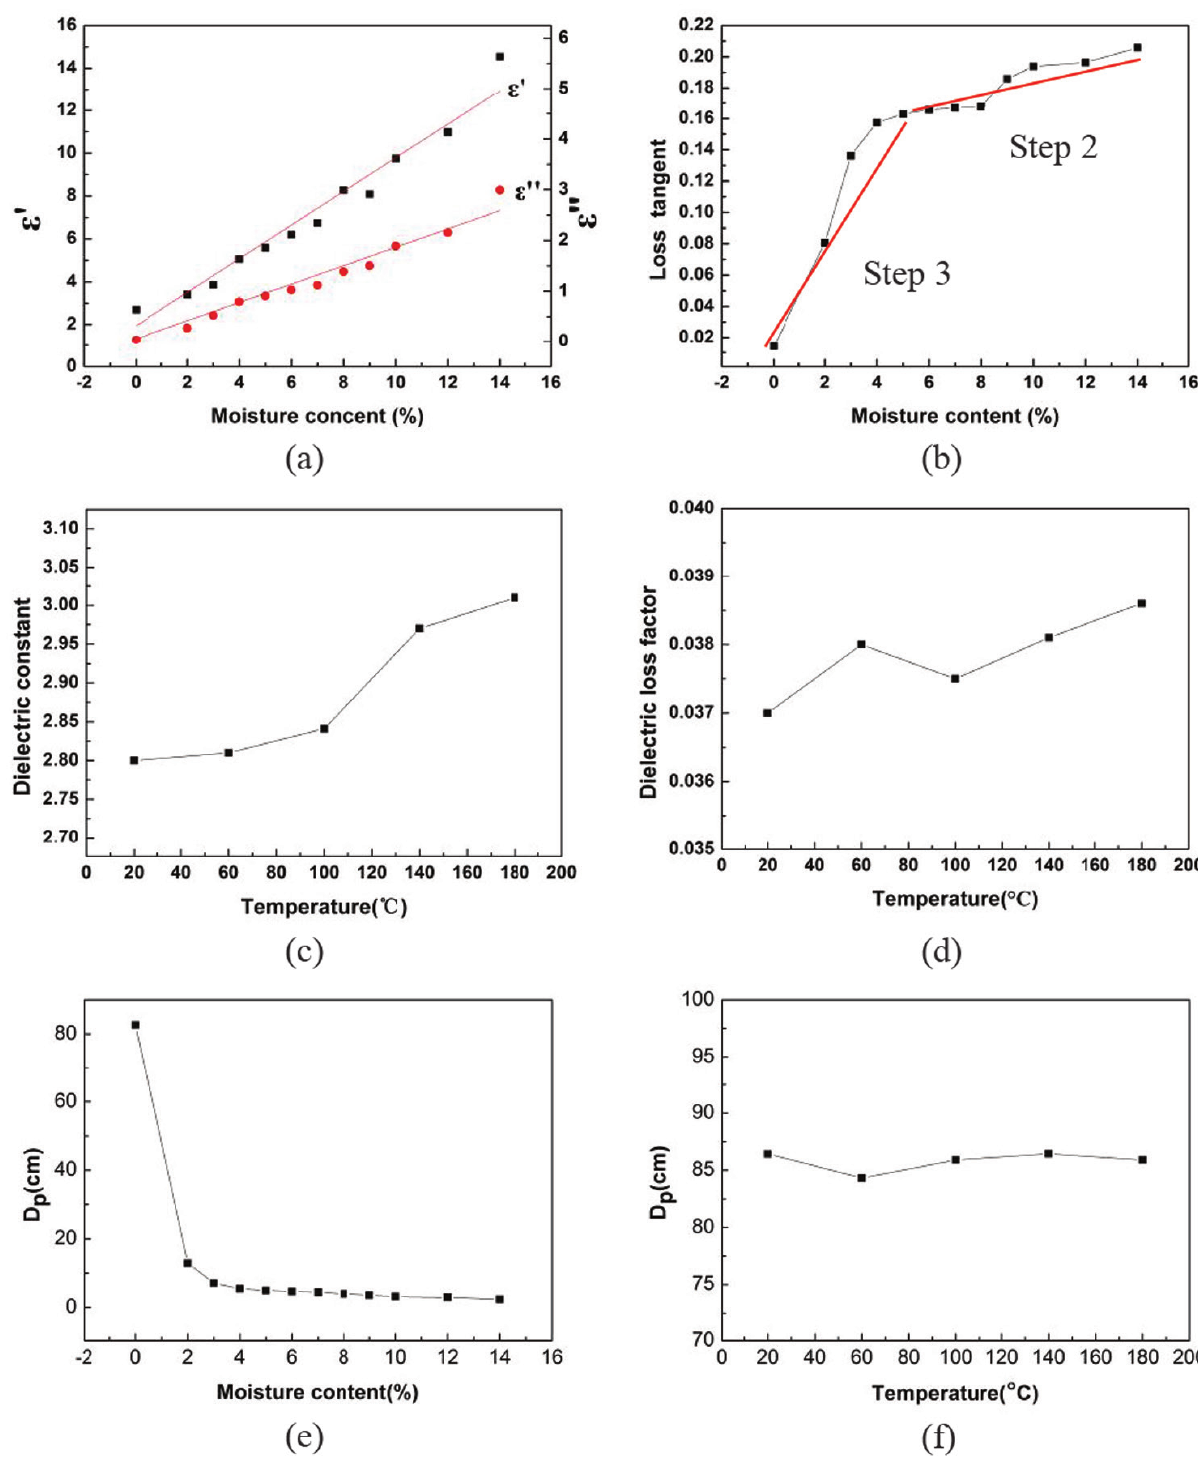
Figure 4: Dielectric properties of the NCR for different moisture content and temperature. (a) Dielectric constant (ε’) and loss factor (ε’’) for different moisture content. (b) Dielectric loss angle tangent (tanδ) for different moisture content. (c,d) Dielectric constant (ε’) and loss factor (ε’’) for the dried sample at different temperature. (e,f) Penetration depth (D